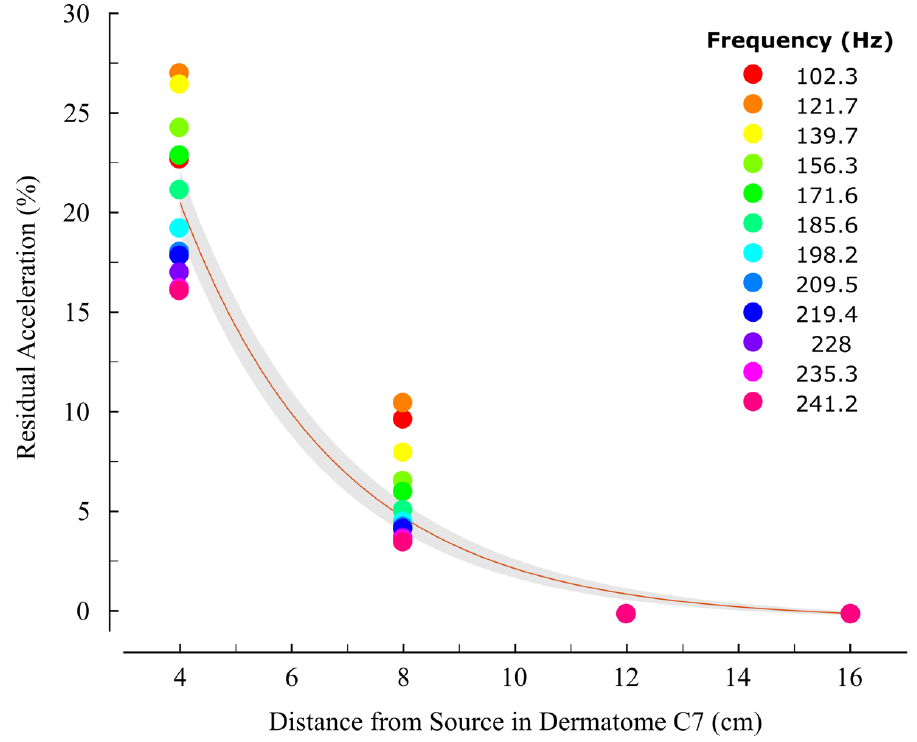
Figure 3. Percentage of acceleration remaining decreases as the distance from the source vibration increases. Data points represent remaining acceleration at the stimulation intensity. Red line indicates the non-linear fitted exponential curve, averaged across the 12 vibration intensities. Gray shaded region indicates the SEM of the fit.